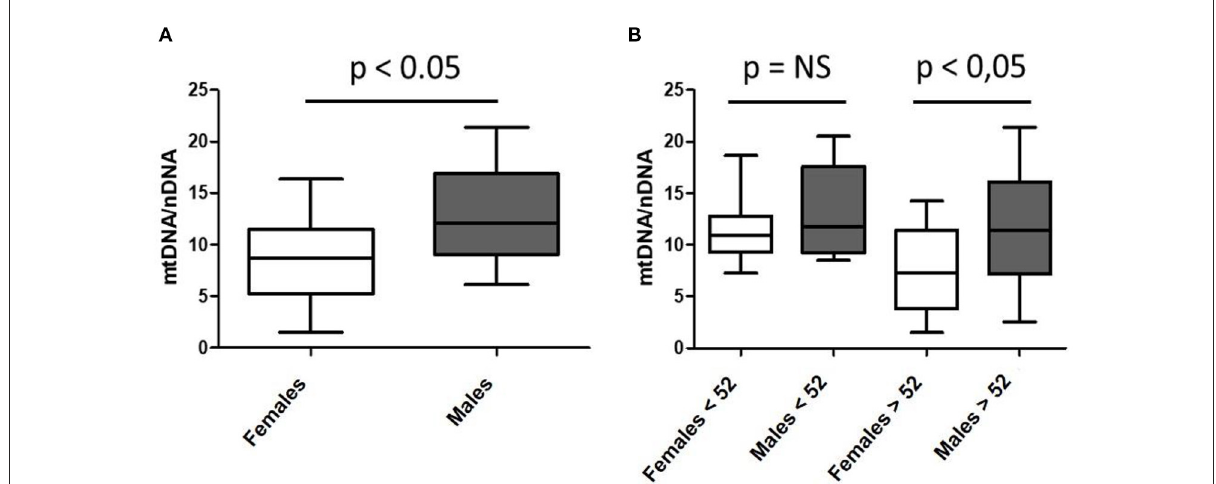
FIGURE1 Sex-differential mitochondrial DNA (mtDNA) content in skeletal muscle of a cohort of healthy subjects according to mean age of menopause onset. (A) n = 53; 34 females and 19 males; mean age 55.94 ± 19.50 and 57.68 ± 15.06 years; (B) pre- and post-menopausal females ( n = 13 and n = 21, respectively) and age-paired males ( n = 8 and n = 11,